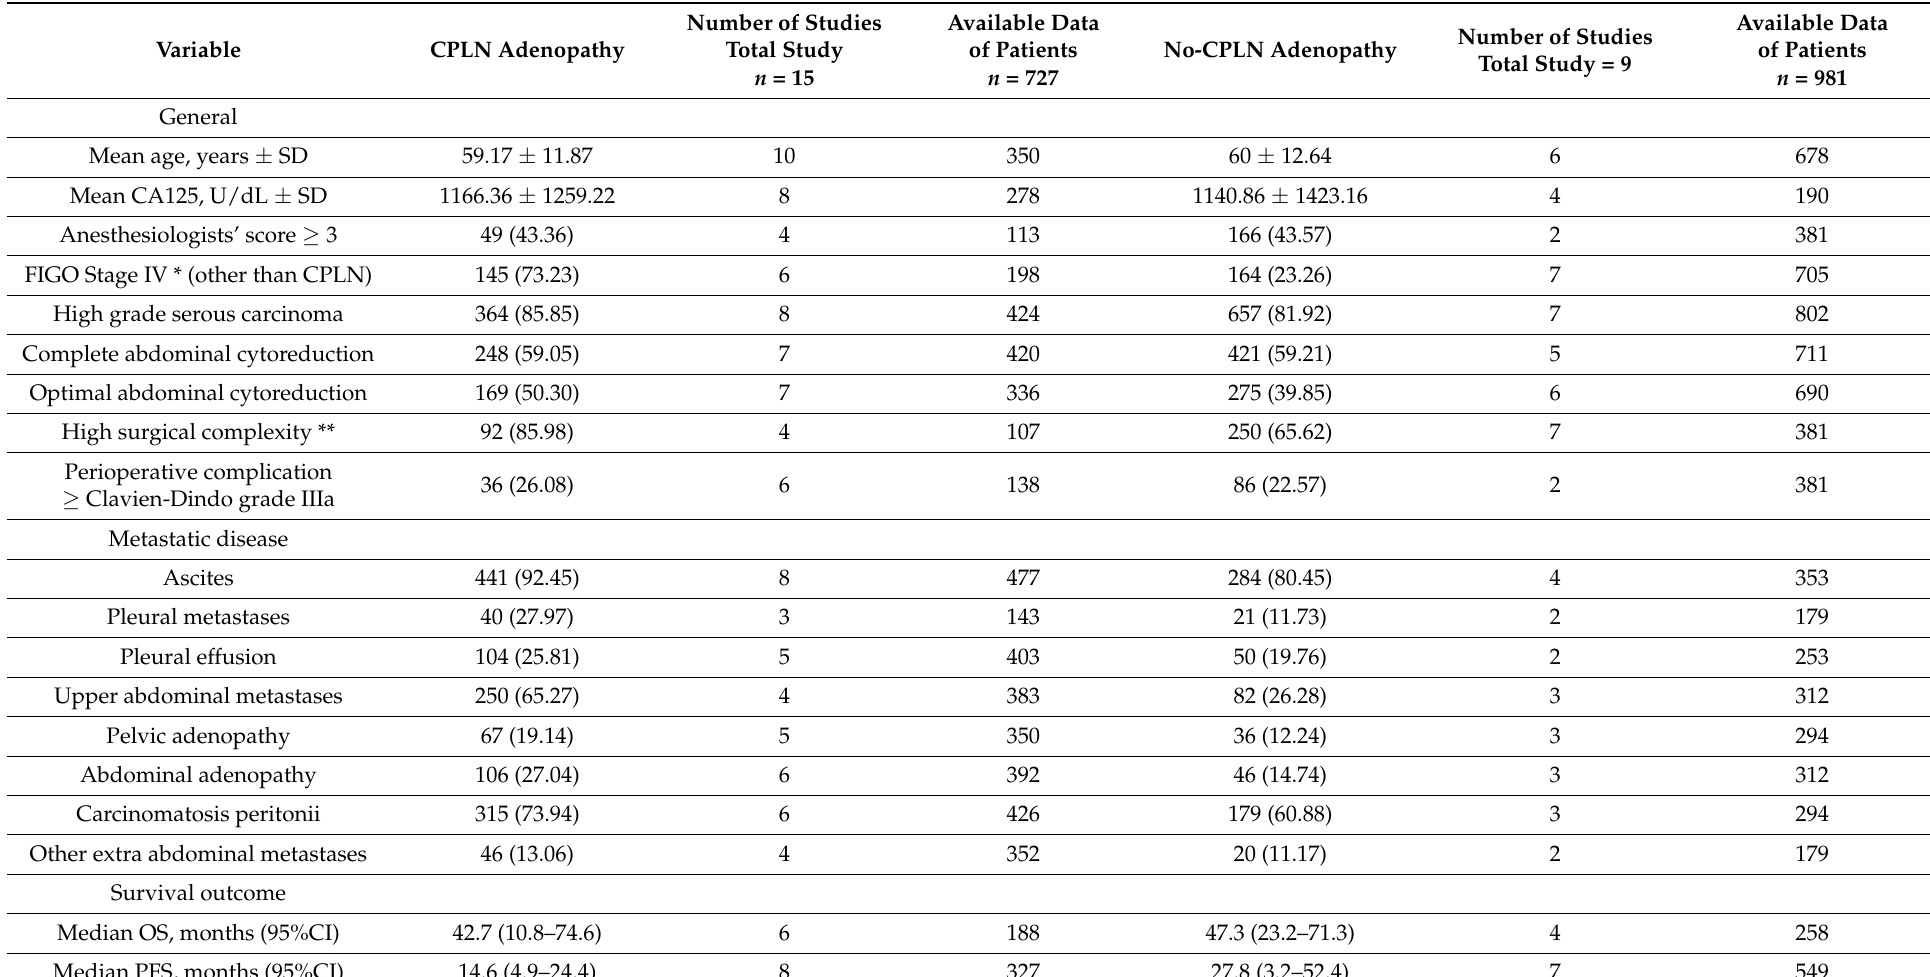
Table 1. Pooled baseline characteristics of patients included in the systematic